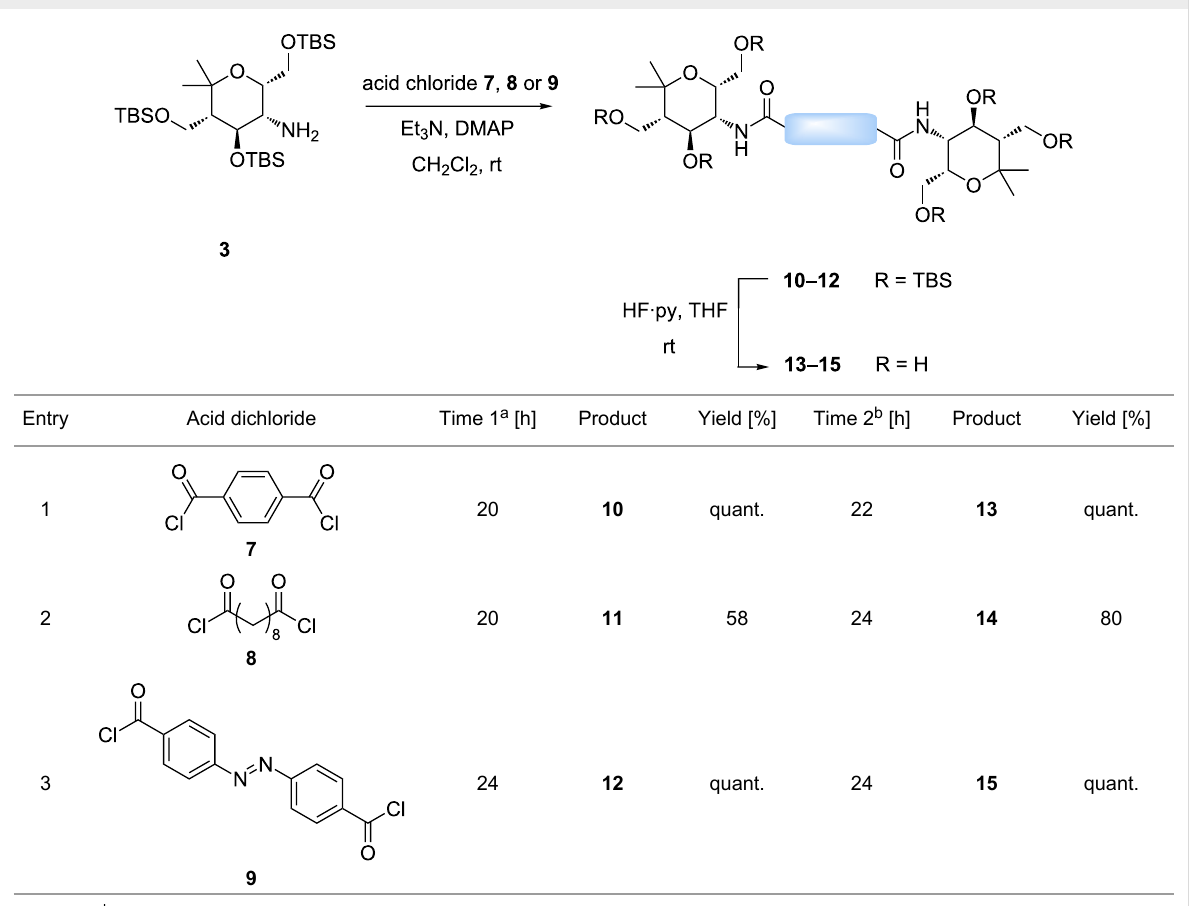
Table 1: Synthesis of amides 10 – 12 and subsequent deprotection to give divalent compounds 13 – 15